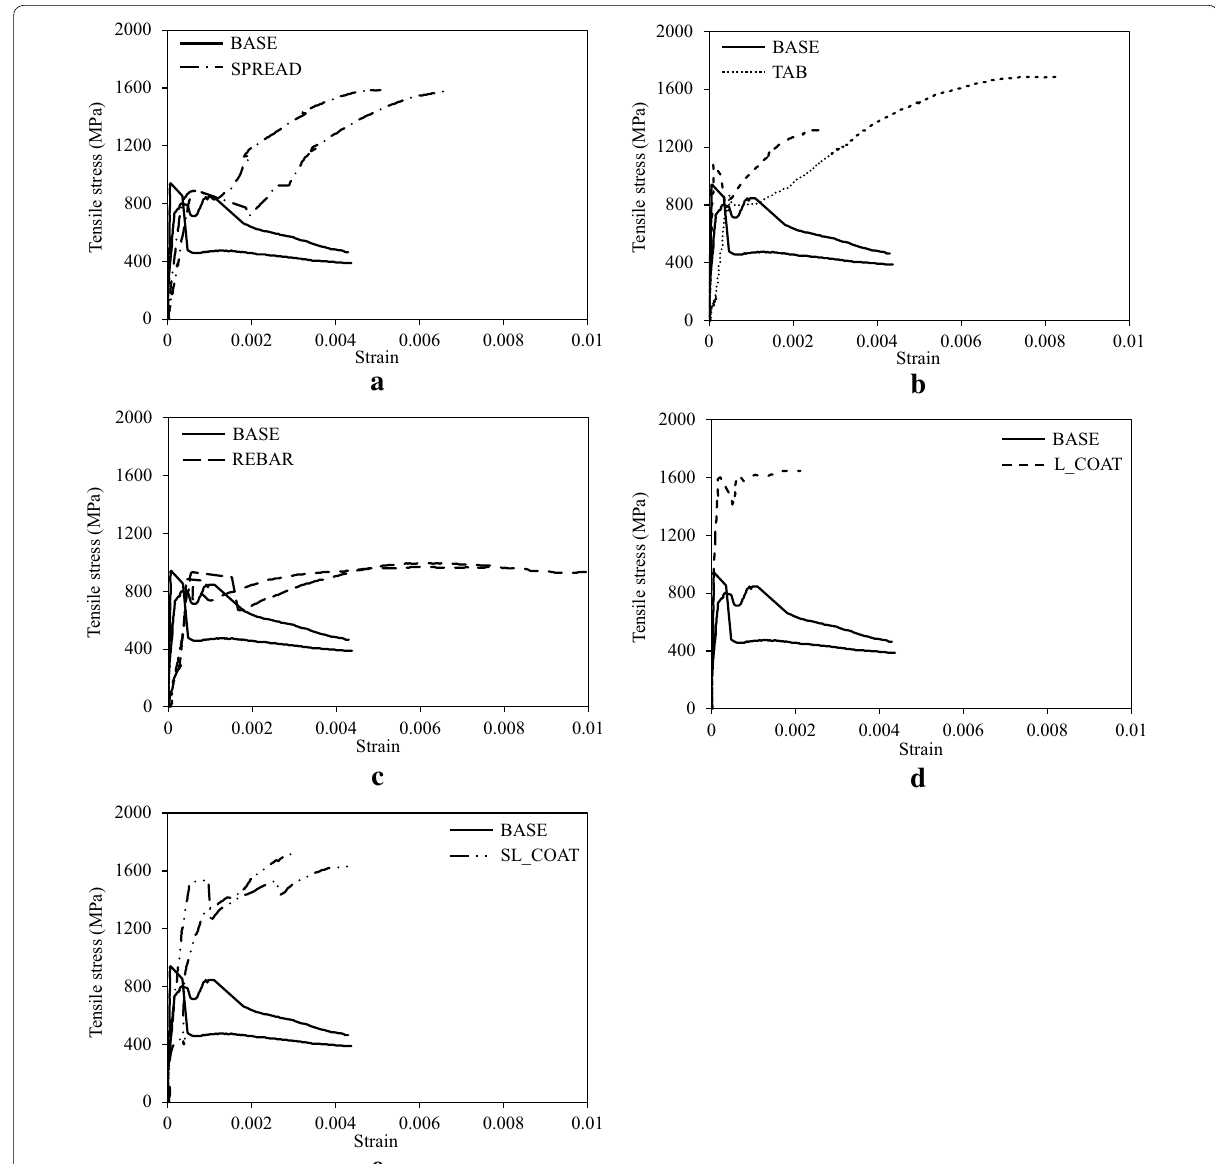
Fig. 8 Effect of anchorage methods on tensile behaviors of test specimens. a Effect of SPREAD method, b Effect of TAB method, c Effect of REBAR method, d Effect of L_COAT method, e Effect of SL_COAT